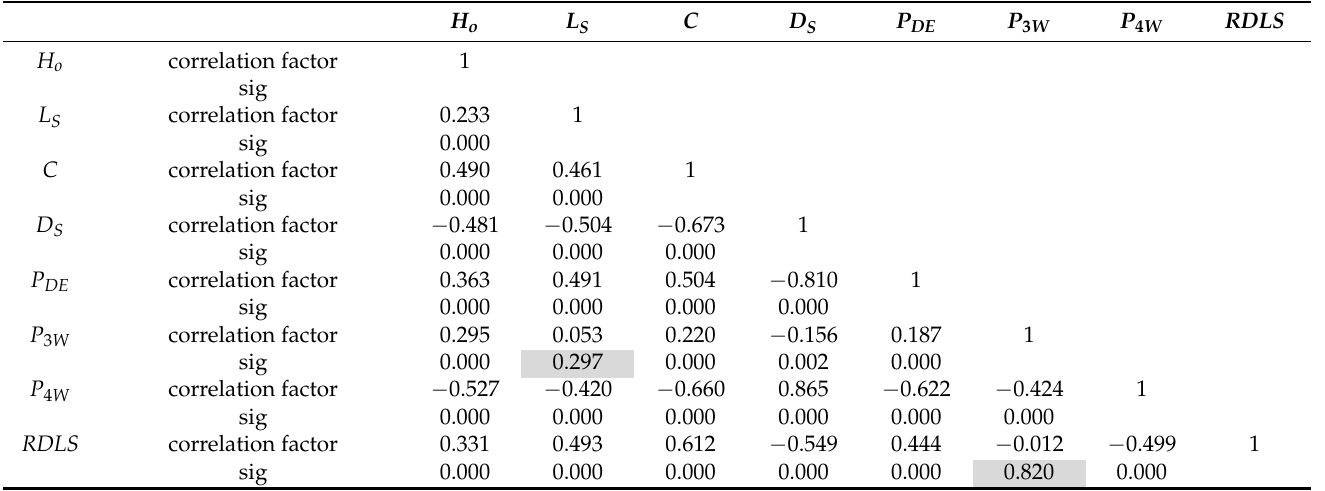
Table 3. Calculation results of the correlation coefficient and hypothesis